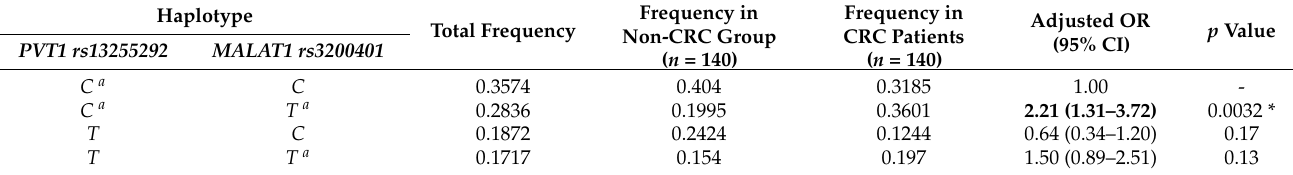
Table 4. Association of haplotypes with CRC